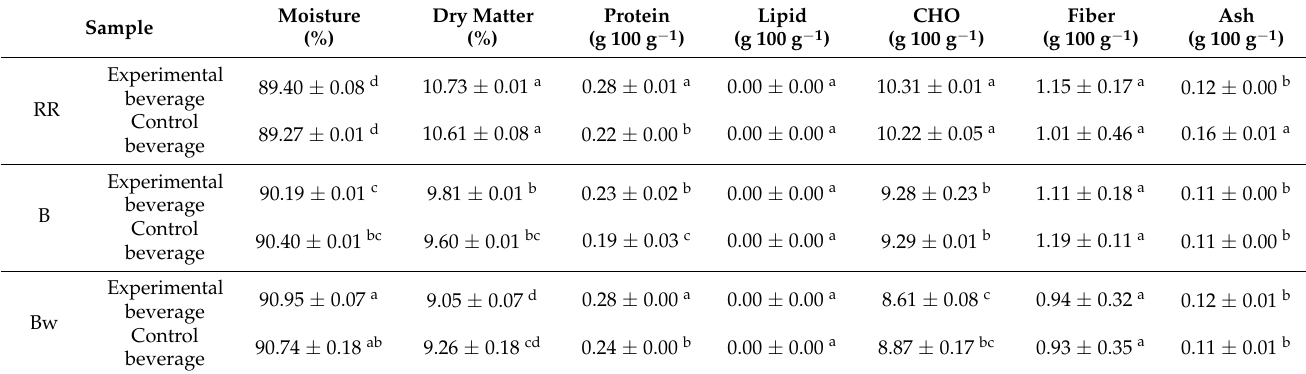
Table 6. Proximate composition of the prototypes of fermented beverages and control beverage made with red rice (RR), barley (B) and buckwheat